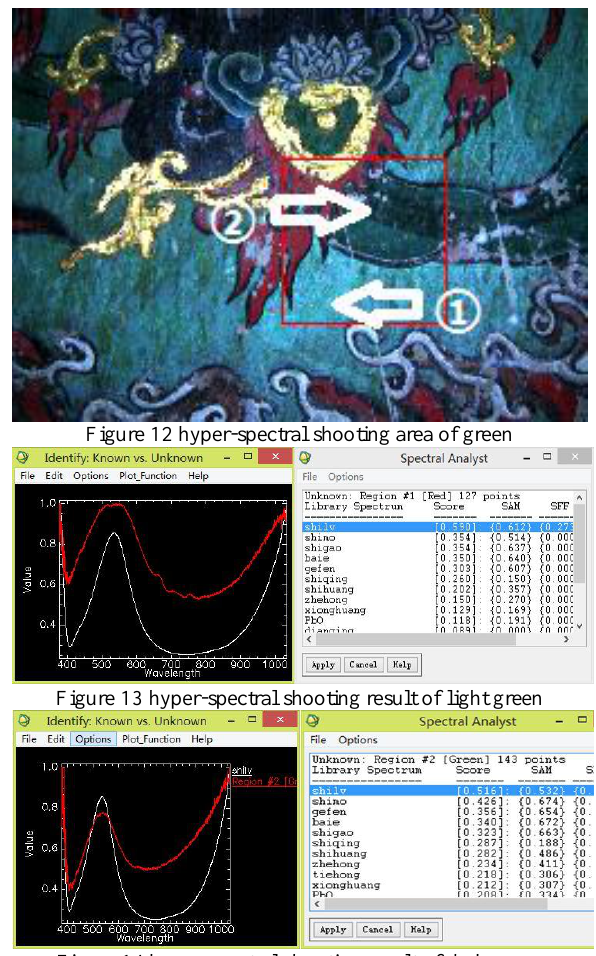
Figure 14 hyper-spectral shooting result of dark